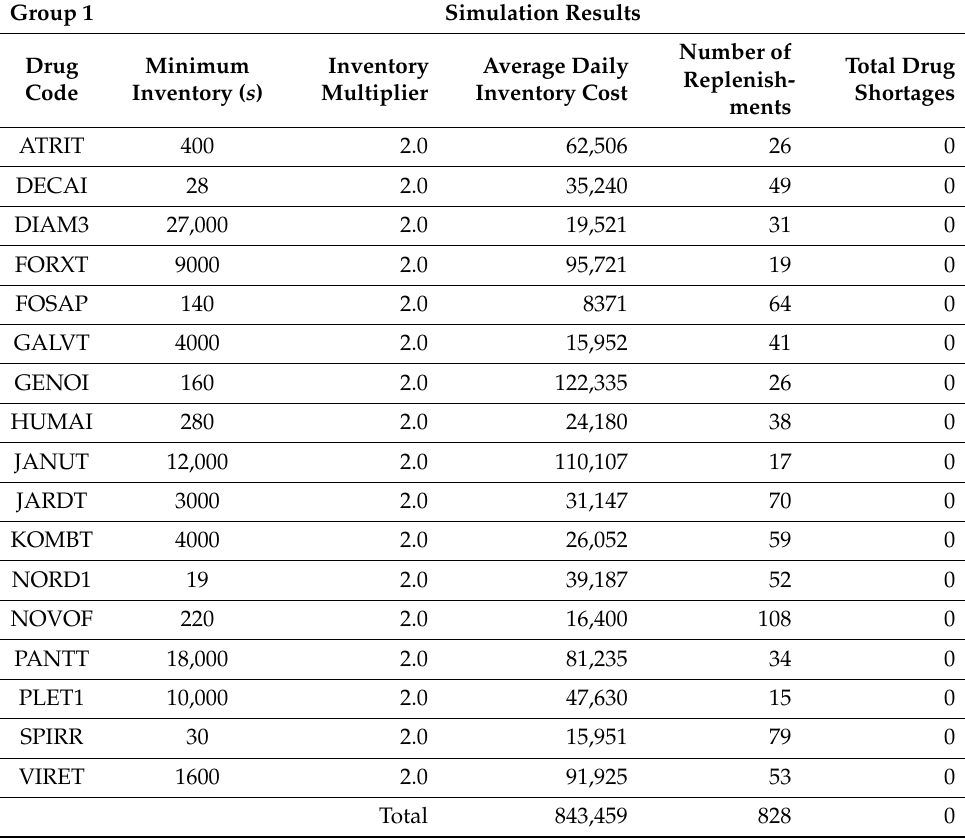
Table 4. Results for 17 drugs in Group 1 for Scenario